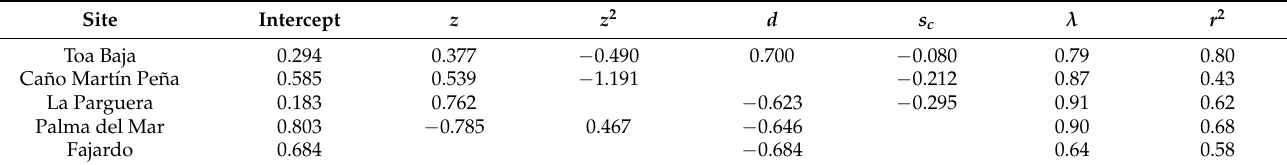
Table 3. Spatial regression of normalized pre-hurricane canopy height ( h ) on normalized covariates. z , the elevation; d , the normalized algorithm-derived tree density; s c , the distance to the coast; λ , the spatial autocorrelation coefficient; r 2 , the coefficient of determination. All coefficients were significant at α =